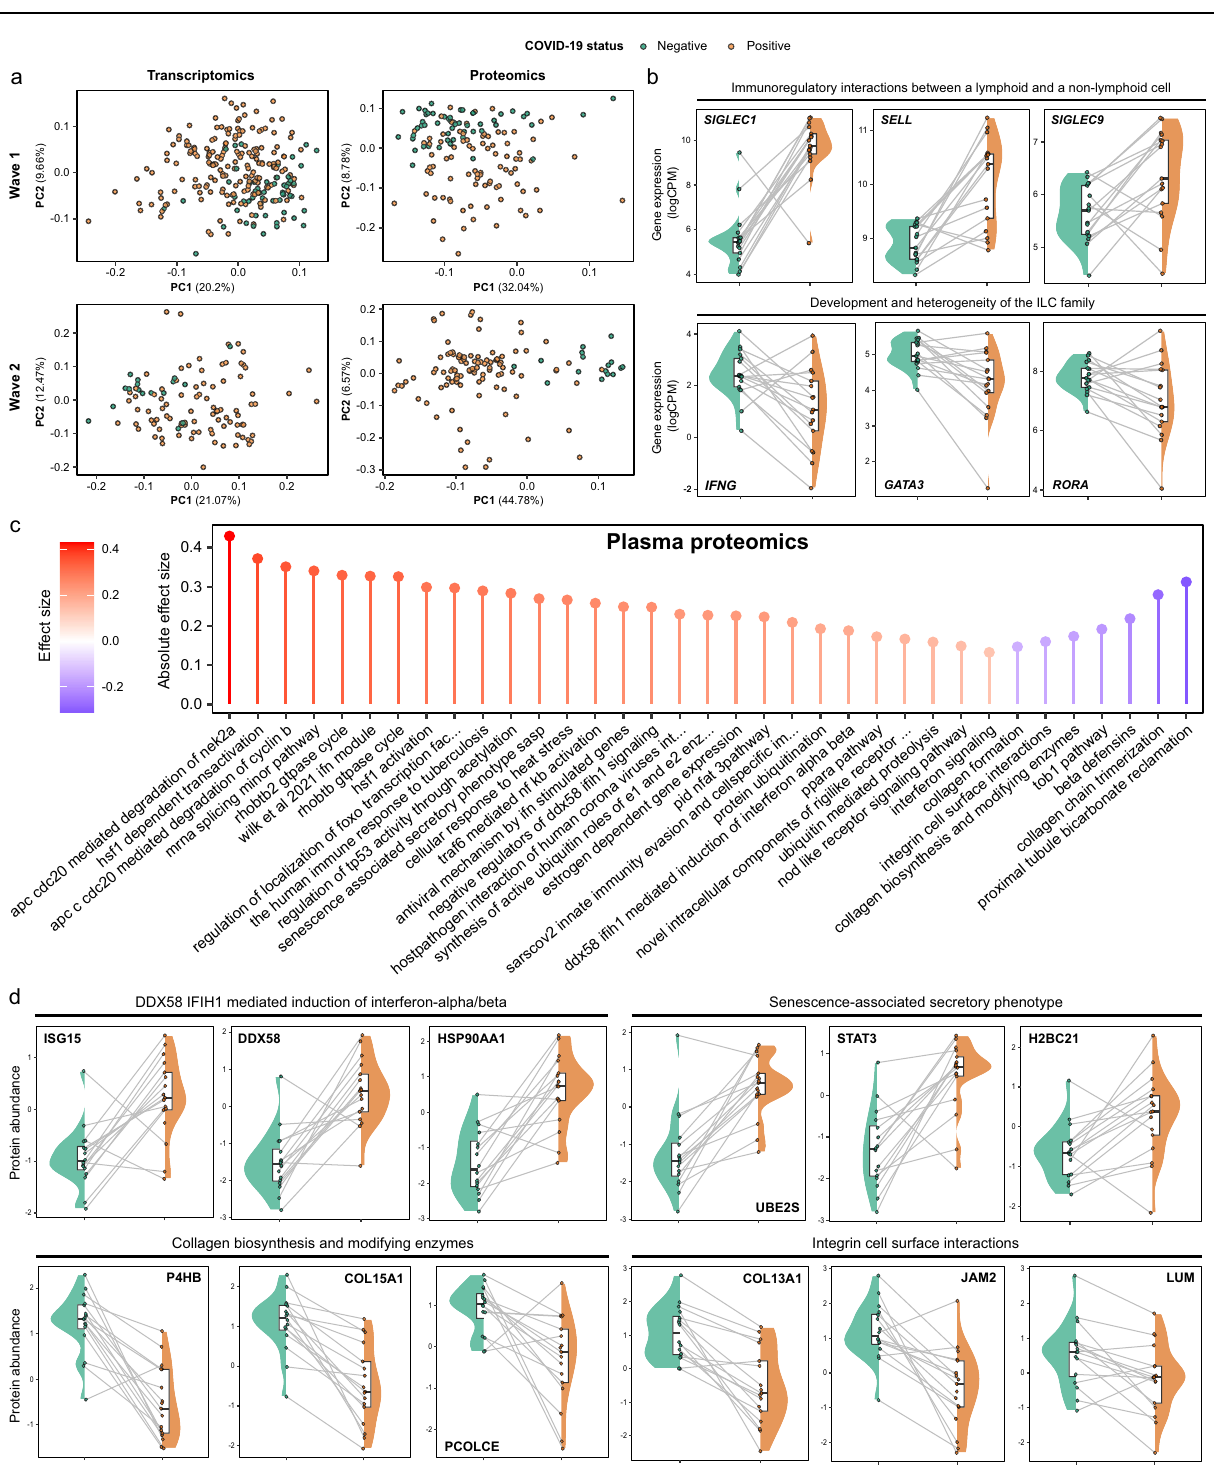
Fig. 2 | Signatures of COVID-19 in ESKD. a PCA of the PBMC transcriptome (left) and plasma proteome (right). Each point represents a sample and is coloured by COVID-19status. b Paired violinplotsshowingintra-individualcomparisons of pre- infection and most severe sample (Wave 2 cohort; n =34 samples from 17 indivi- duals) during COVID-19 for selected genes. Grey lines link each individual ’ s pre- infection and infection samples; these samples are represented by points and coloured by COVID-19 status. Shaded areas indicate kernel density estimates. For boxplots, centre = median, upper bound = upper quartile, lower bound = lower quartile. All genes shown were signi fi cantly differentially expressed (1% FDR) in